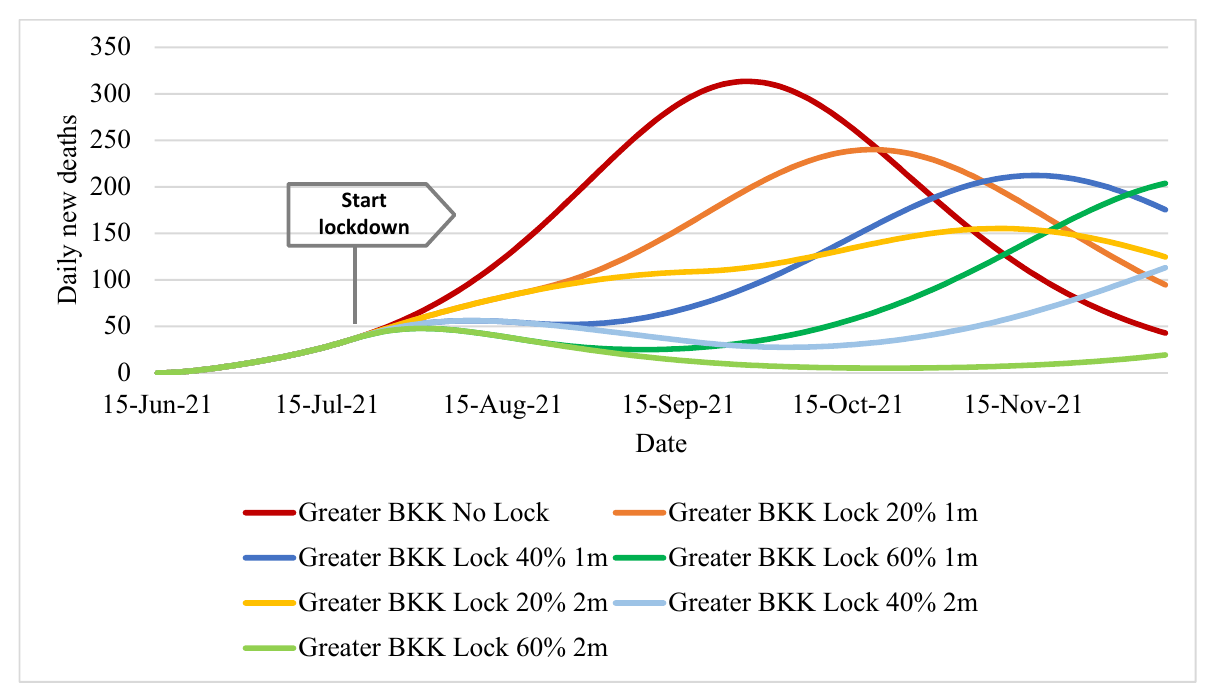
Figure 4. Daily new deaths in Greater Bangkok.